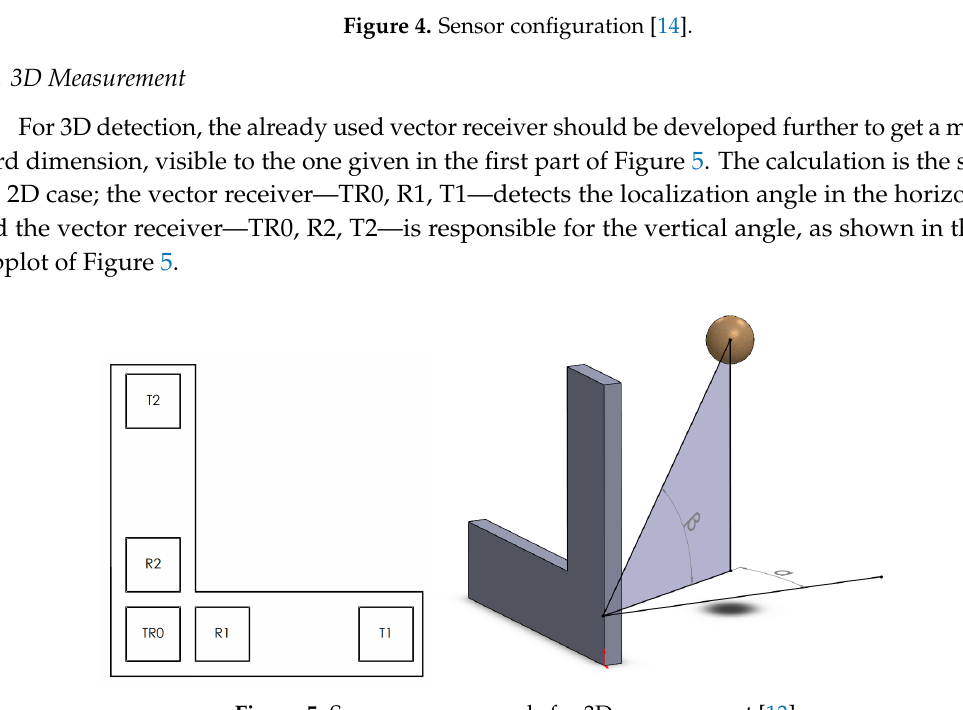
Figure 5. Sensor array example for 3D measurement